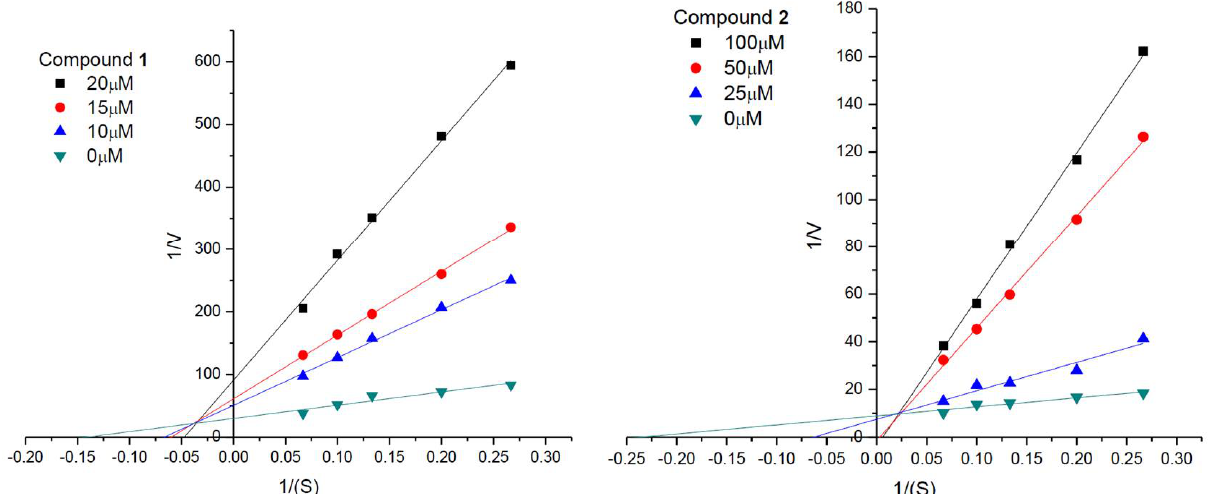
Figure 4. Lineweaver–Burk plots for the inhibition of AChE by compounds 1 and 2 .